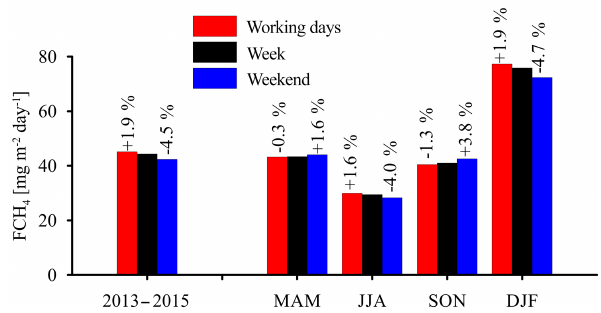
Figure 7. Mean daily values of FCH 4 in the period July 2013– June 2015 calculated for study period and seasons. Red, black and blue bars indicate mean daily exchange during, respectively, work- ing days (Monday to Friday), weeks (Monday to Sunday) and week- ends (Saturday and